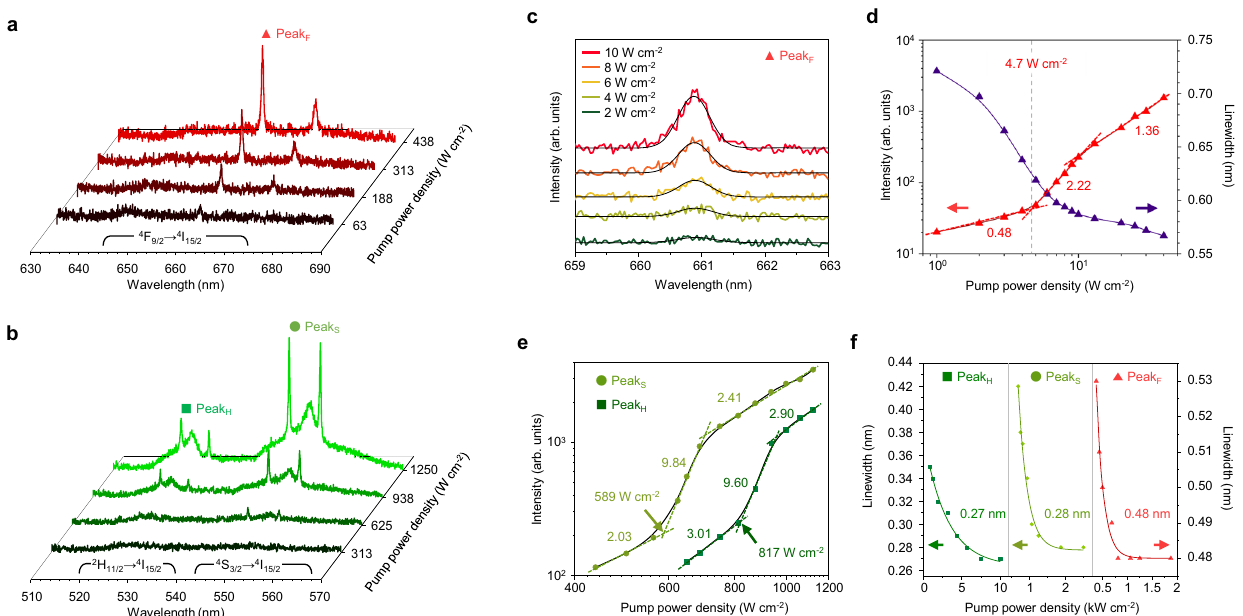
Fig. 2 Ultralow-threshold continuous-wave upconversion lasing. a , b . Red- ( a ) and green-band ( b ) emission spectra of an LQUM doped with Yb 3 + and Er 3 + around the lasing threshold. The laser lines corresponding to 2 H 11/2 → 4 I 15/2 , 4 S 3/2 → 4 I 15/2 and 4 F 9/2 → 4 I 15/2 are labeled as Peak H , Peak S, and Peak F , respectively. c , d Laser emission spectrum of Peak F near the laser threshold of sub-10 W cm − 2 ( c ) and a laser emission intensity and linewidth measurement ( d ). e Generation of Peak H and Peak S . f Linewidth saturation of the laser lines with increasing pump power